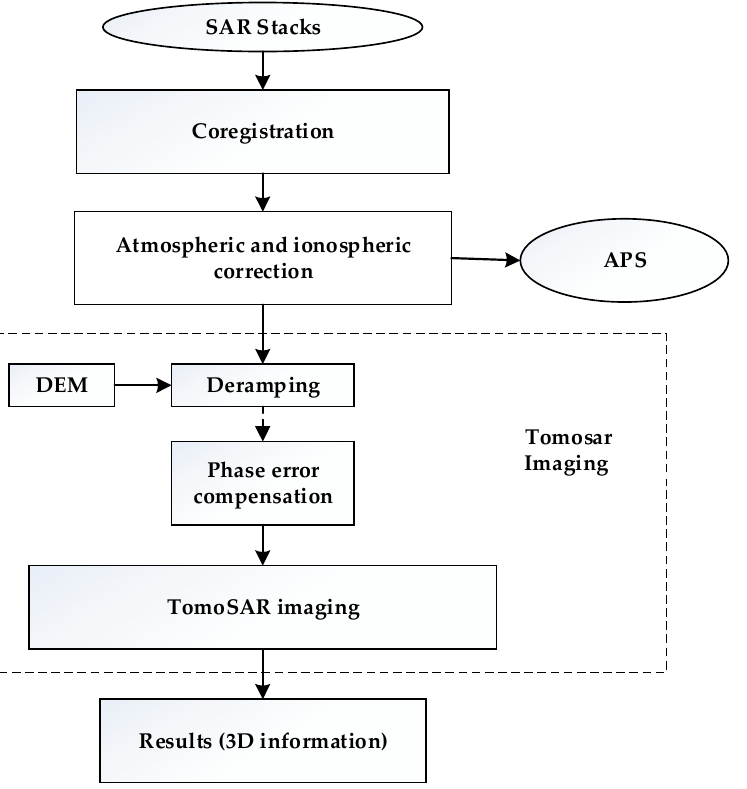
Figure 2. The workflow of the 3D tomographic SAR imaging, APS refers to the atmospheric phase screen, phase error compensation refers to the SAR interferometry phase with the DEM error phase calibration in this study.